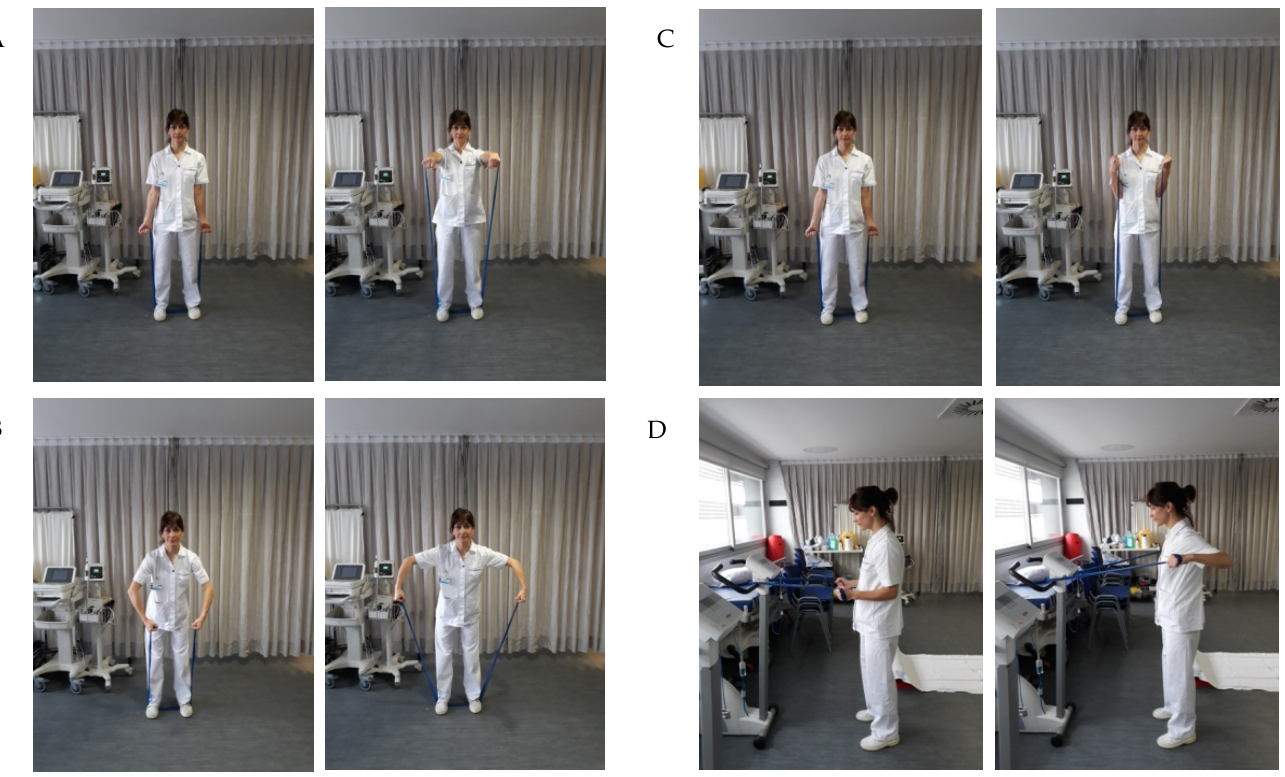
Figure 2 A - D. Exercise protocol of upper limbs performed by patients. These exercises 217 Figure 2. ( A – D ). Exercise protocol of upper limbs performed by patients. These exercises were were designed to improve the strength of the upper limb. Anterior deltoids (A), middle 218 designed to improve the strength of the upper limb. Anterior deltoids ( A ), middle deltoids ( B ), biceps deltoids (B), biceps (C) and dorsal muscles (D). 219 ( C ) and dorsal muscles ( D